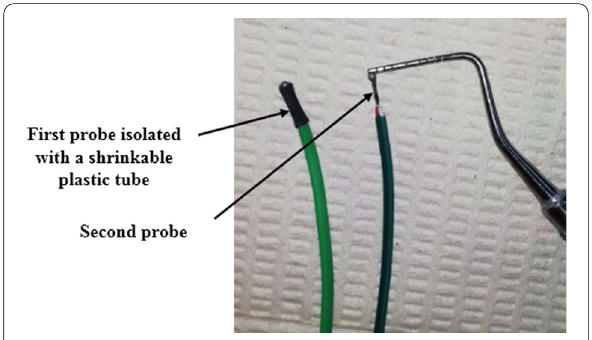
Fig. 2 Two separate K-type thermocouple probe one of them was isolated with heat shrinkable plastic